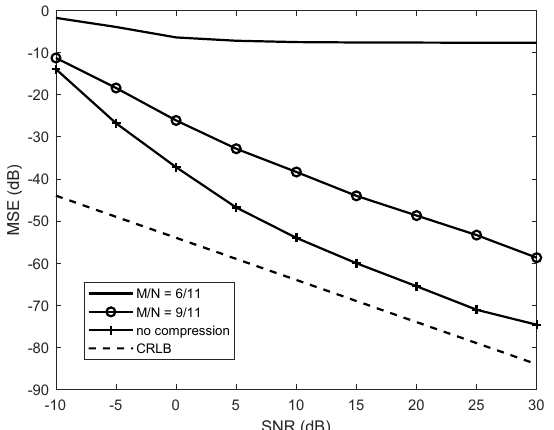
Figure 2. Frequency estimation mean square error versus SNR, the colored noise case, using CCS with different compression ratios, as well as the estimator without compression [27]. ω o = π /8 rad, α = 5, B = 10, p = 5, q = 10.